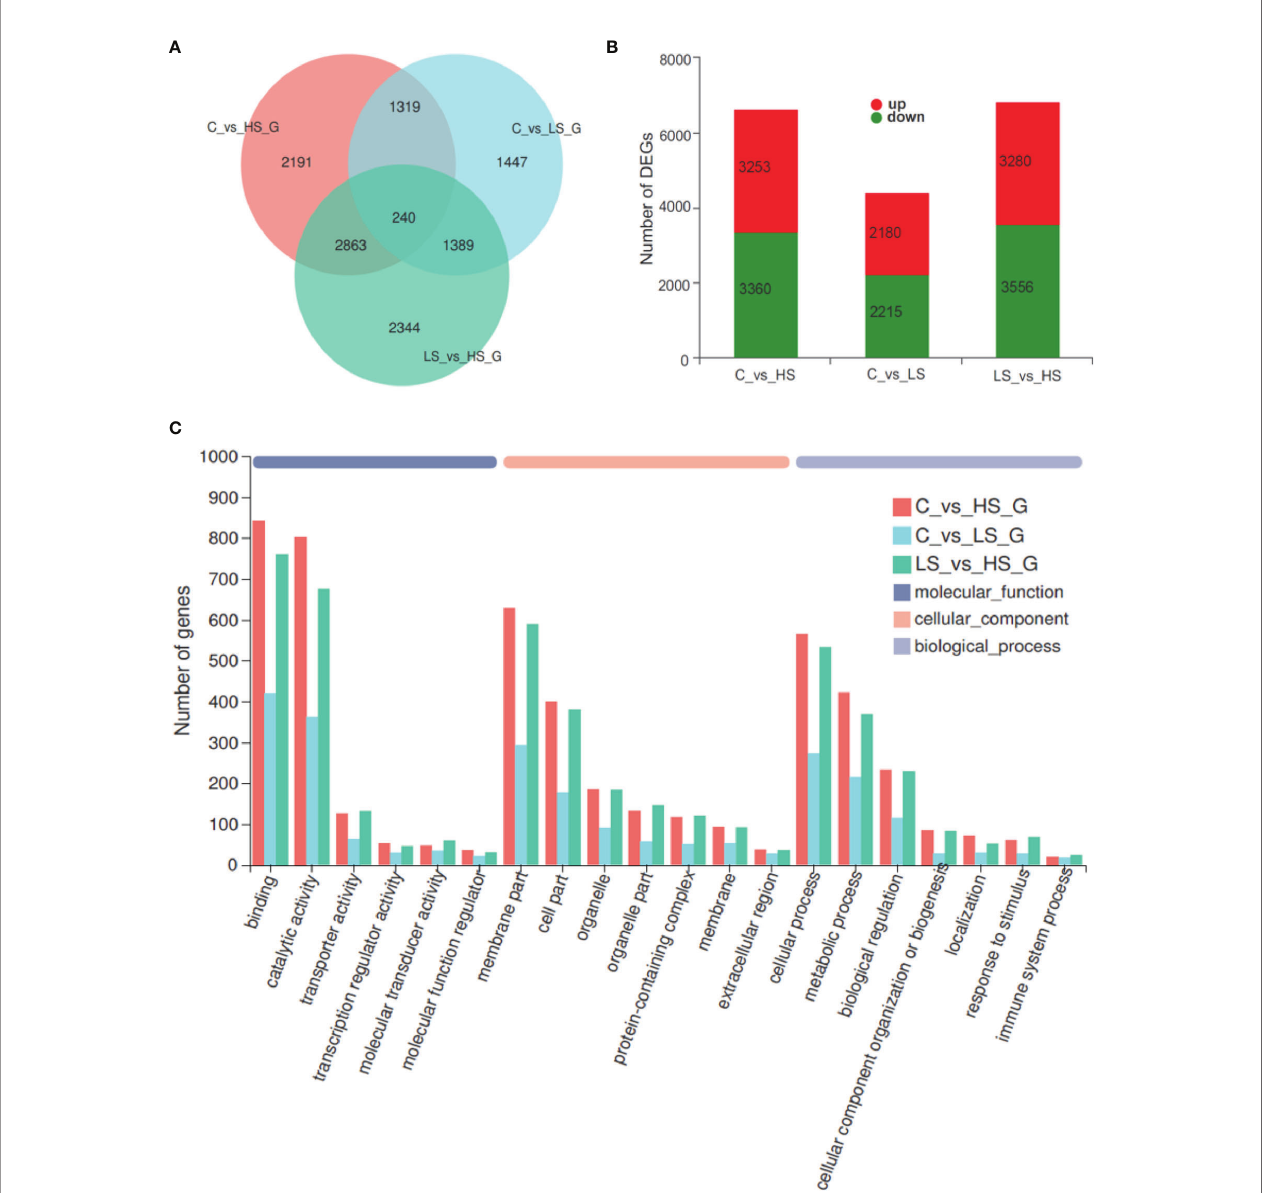
FIGURE 3 | Statistics and GO categorization of the DEGs in the gill transcriptome of Pinctada maxima . (A) Venn diagram of the number of DEGs, (B) statistics for up/down-regulated DEGs, and (C) GO categorization of the DEGs. C, control group; HS, high salinity group; LS, low salinity